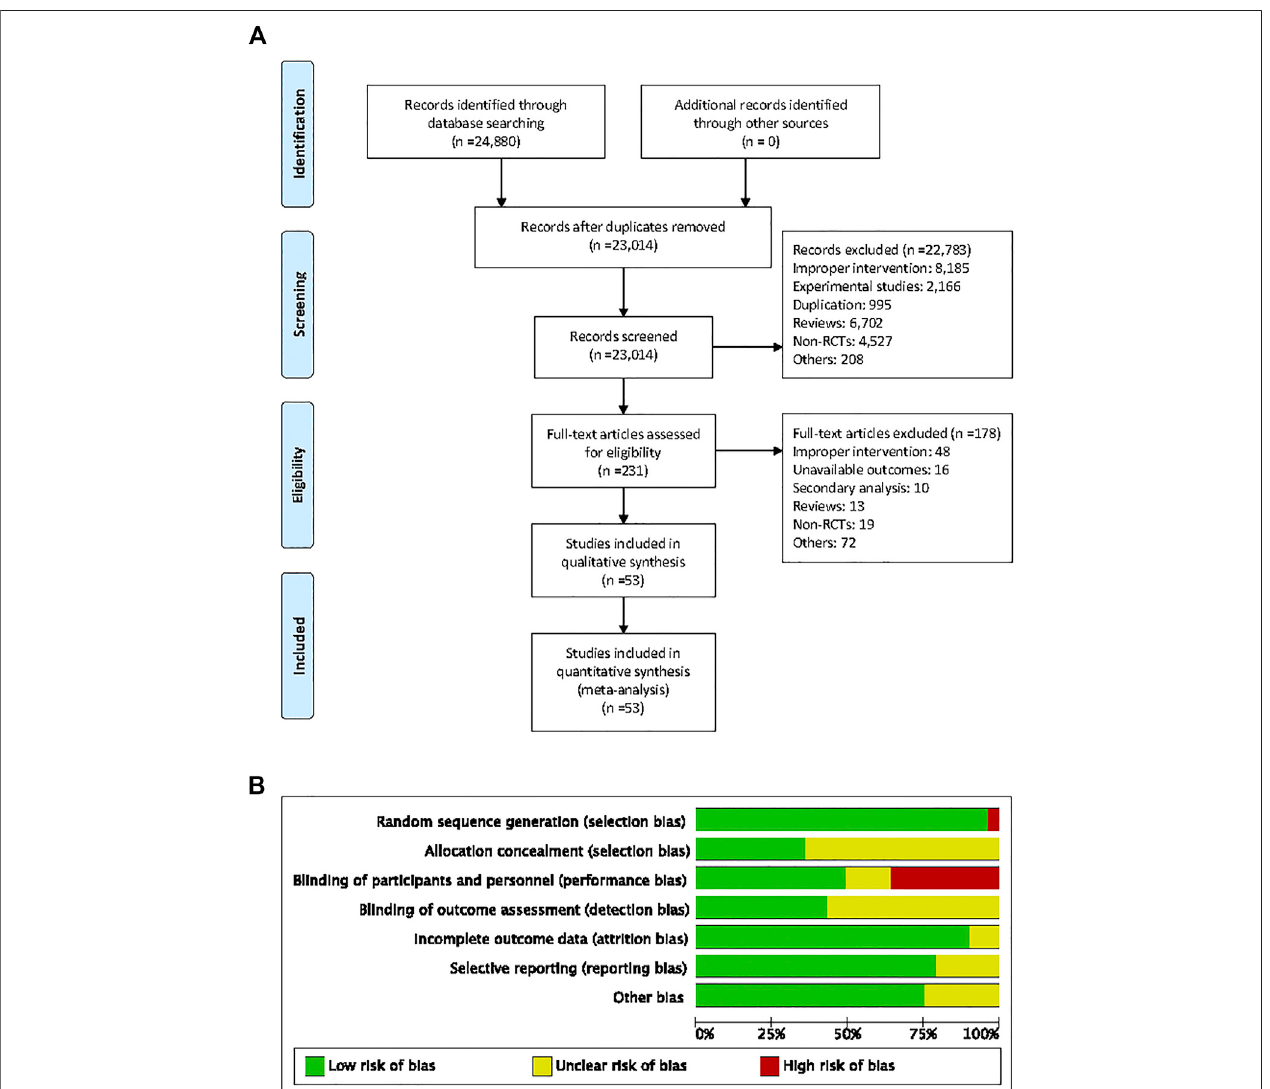
FIGURE 1 | Flow diagram of searching for eligible studies and risk of bias summary. (A) Flow diagram of searching for eligible studies, (B) risk of bias summary.